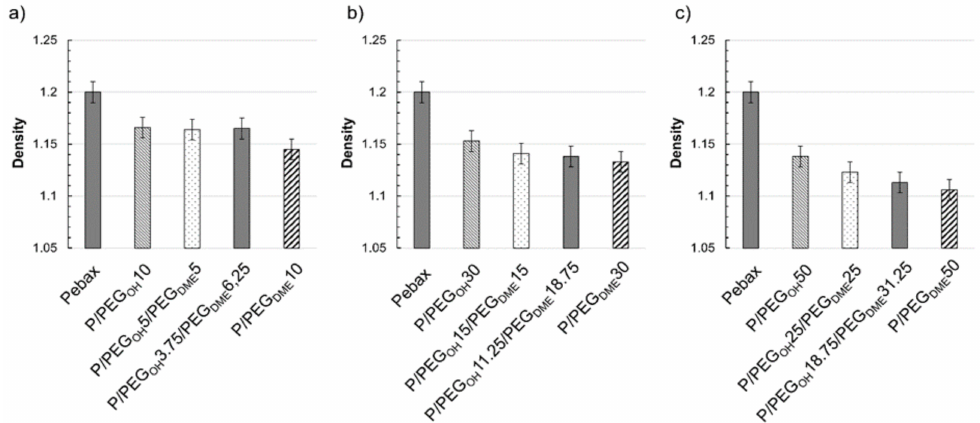
Figure 6. Density values measured for different blend compositions with a total additive amount of 10 wt.% ( a ), 30 wt.% ( b ), and 50 wt.% ( c ).